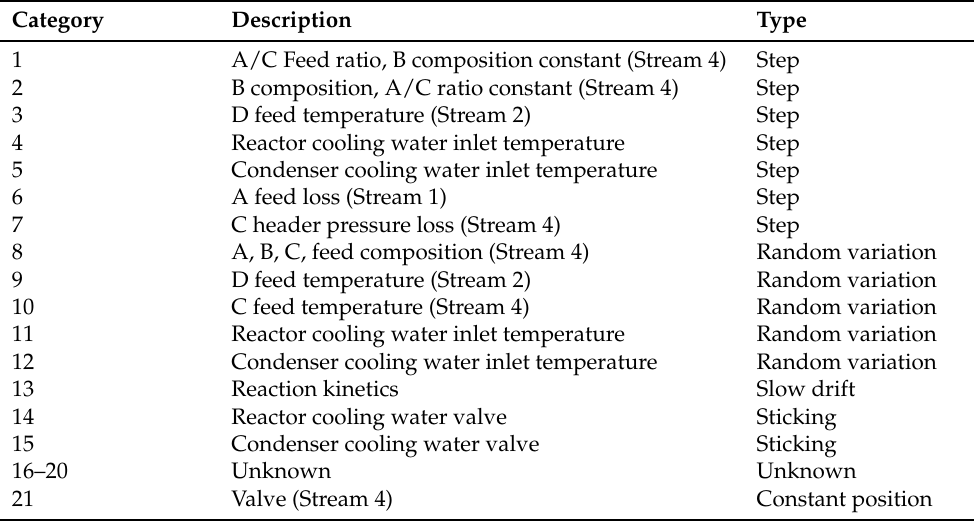
Table 1. Description of fault categories.